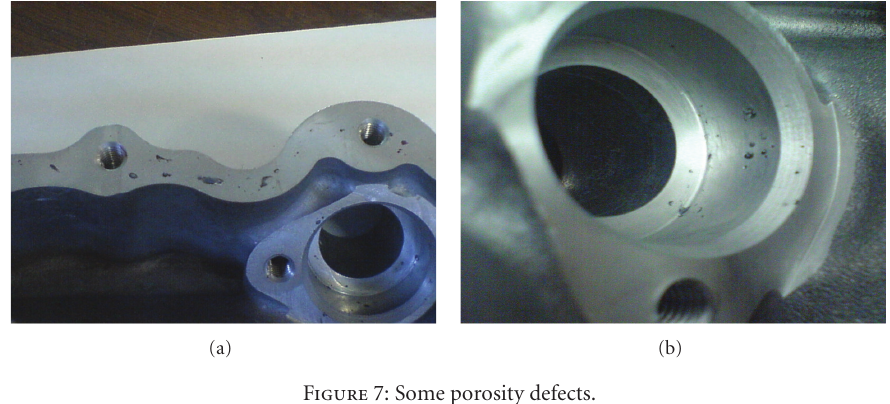
Figure 7: Some porosity defects.